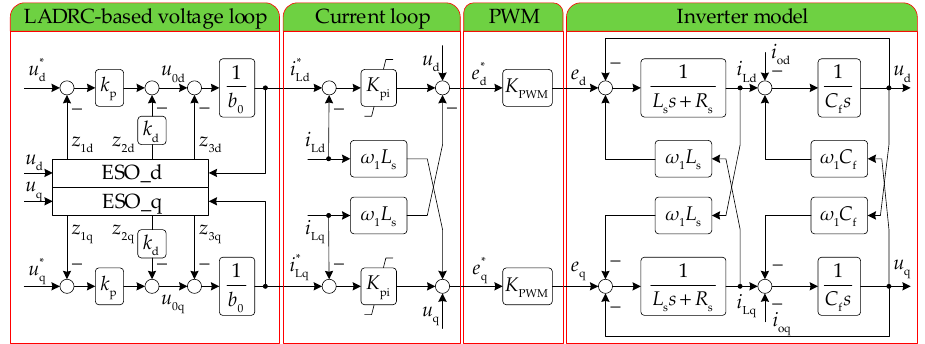
Figure 2. LADRC-based voltage control scheme.